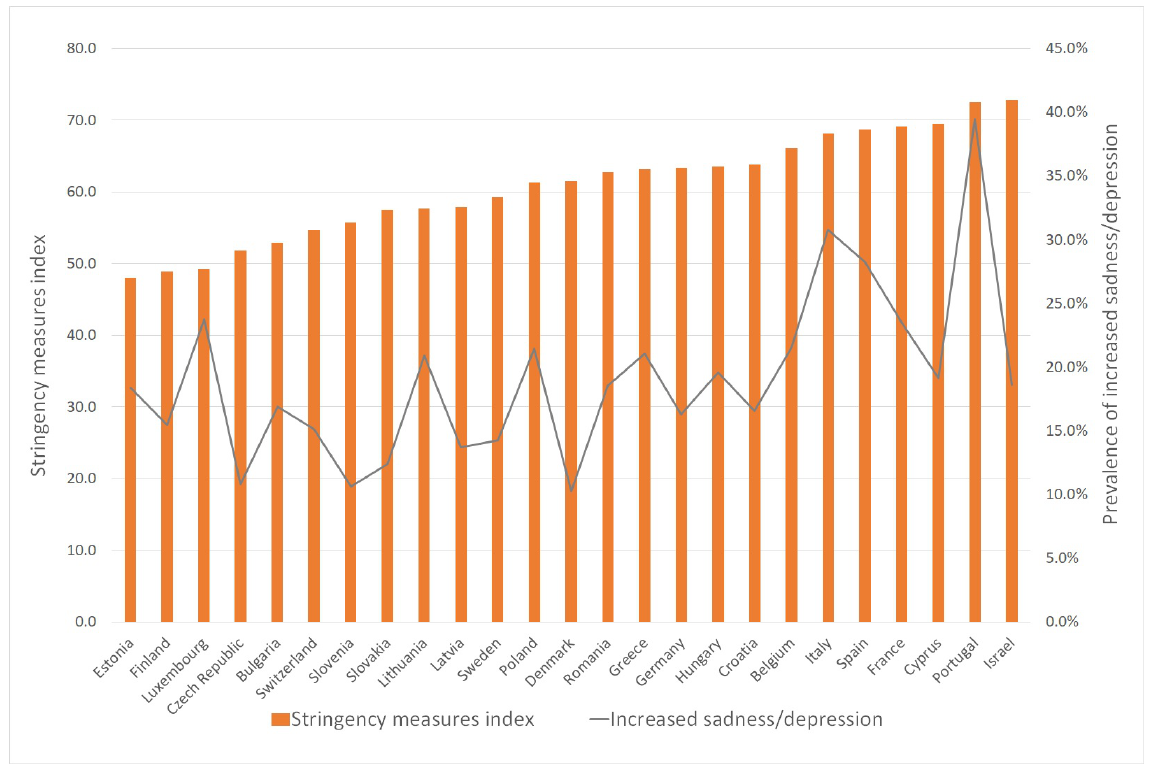
Figure 1. Prevalence of increased sadness/depression by country. Source: Preliminary SHARE COVID-19, wave 8, release 0.0.1 beta. Conclusions are preliminary. Weighted data. Notes: The sample was limited to individuals aged 65+. Table 2. Logistic regression for increased feelings of